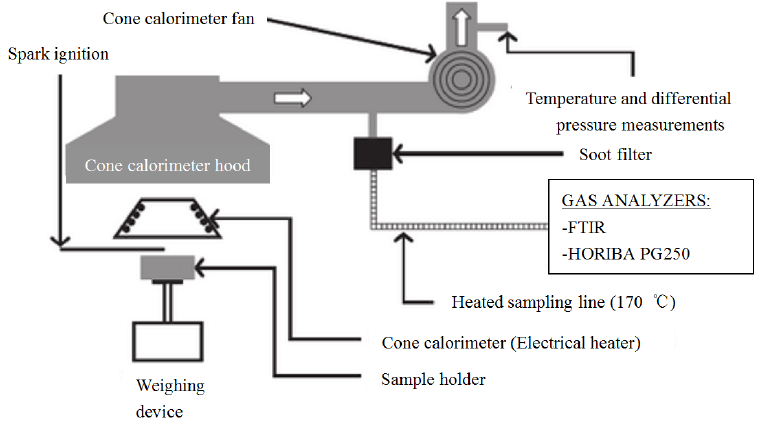
Figure 2. Schematic of a cone calorimeter [27].